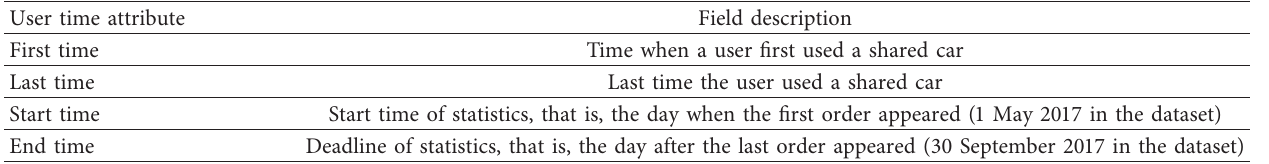
Table 3: Description of user time attributes.